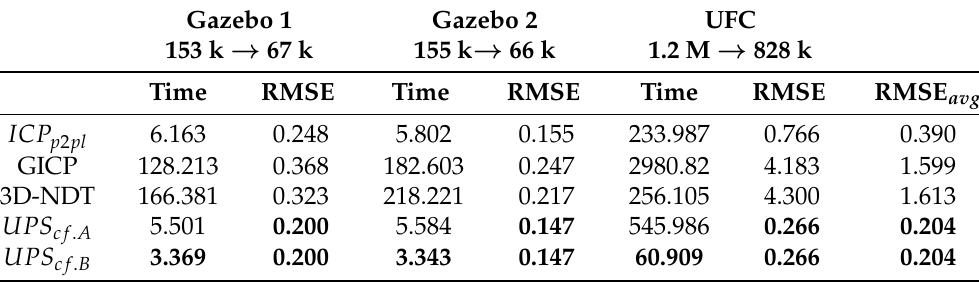
Table 12. Point cloud registration in the case of different cloud size.iew elapsed time (in seconds) and RMSE (in